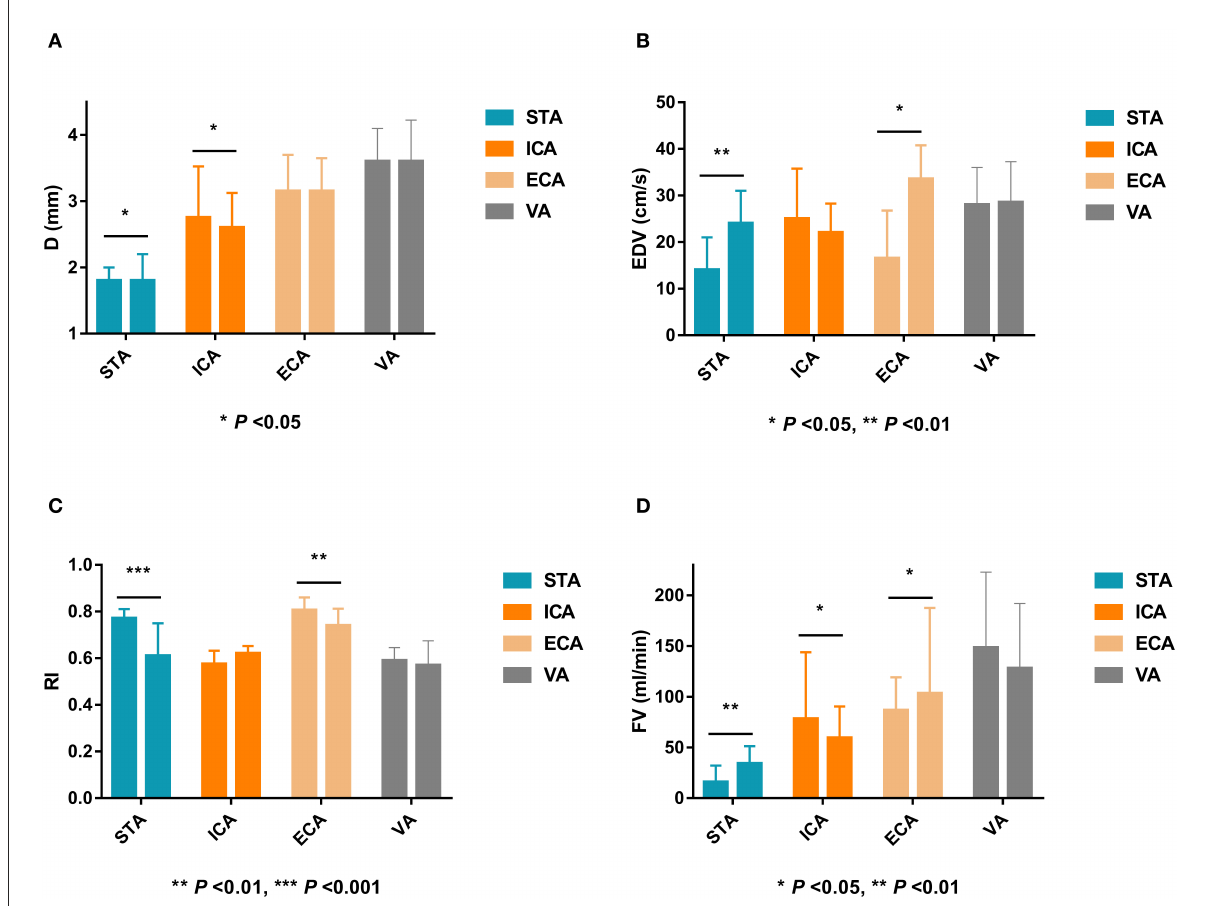
FIGURE3 Ultrasonographic changes of extracranial arteries after EDAS in MMD patients. EDAS, encephalo-duro-arterio-synangiosis; MMD, indicates moyamoya disease; D, inner diameter; STA, superficial temporal artery; ICA, internal carotid artery; ECA, external carotid artery; VA, vertebral artery; EDV, end-diastolic velocity; RI, resistance index; FV, flow